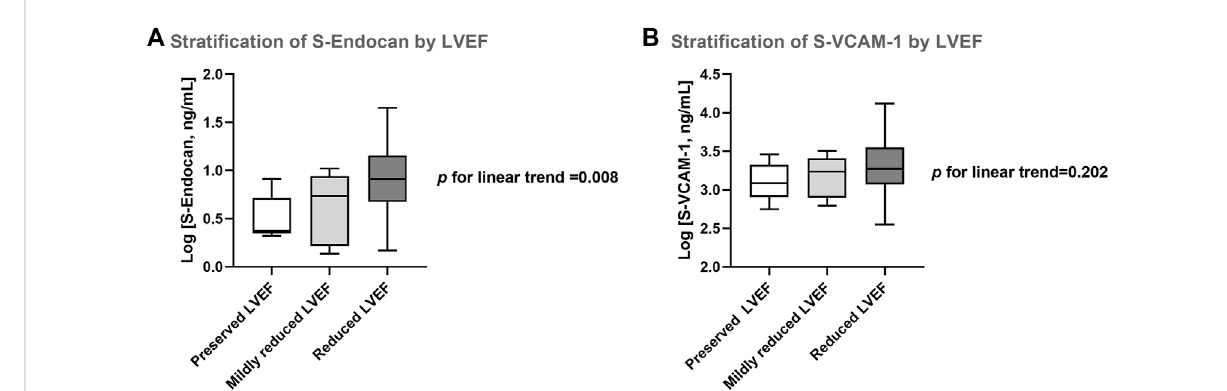
FIGURE 8 Serumendocan (A) and VCAM-1 (B) strati fi edbyleftventricular ejection fraction(LVEF).Preserved LVEF:LVEF ≥ 50%;mildly reduced LVEF:LVEF 41 – 49%; reduced LVEF: LVEF ≤ 40%. Results are presented in Box-and-Whiskers plot. S-Endocan, serum endocan; S-VCAM-1, serum vascular cell adhesion molecule